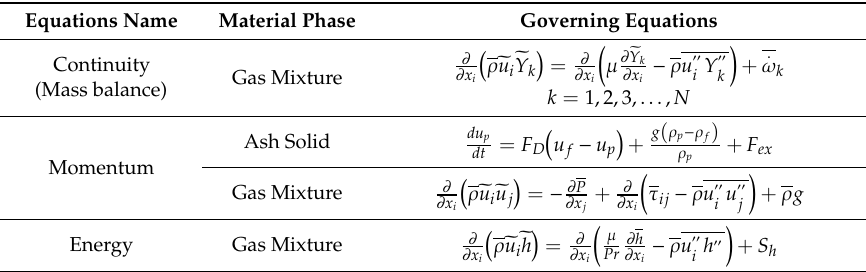
Table 3. Governing equations [30,31] and the chemical reactions [33] related to the gas combustion, reproduced with permission from M. Sa ff ari Pour, Producer Gas Implementation in Steel Reheating Furnaces from Lab to Industrial Scale: A Computational Fluid Dynamics and Thermodynamics Approach, Doctoral Thesis, 2016